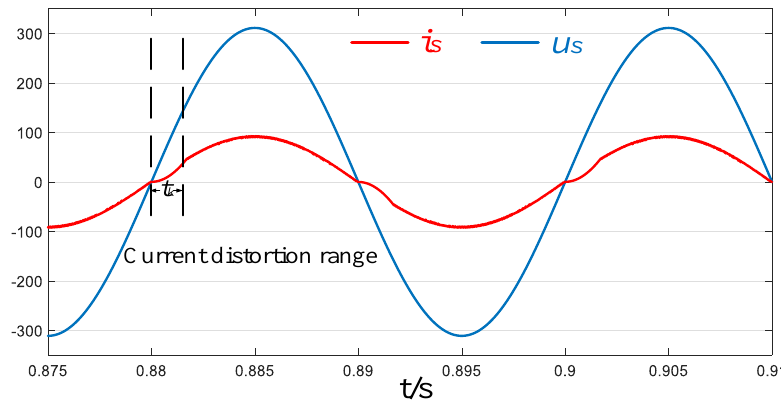
Table 2. Main parameters of the simulation. Parameters